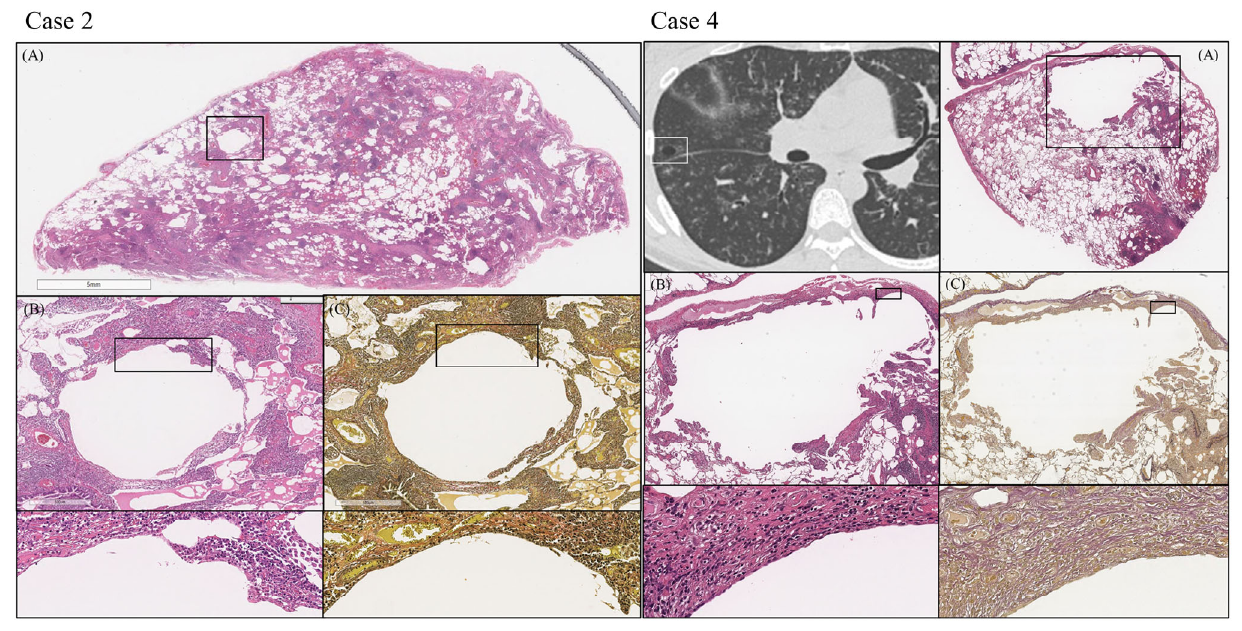
Figure 3. Pathological images of lung cyst. (Case 2 and Case 4). Case 2 is a case of multiple cysts and